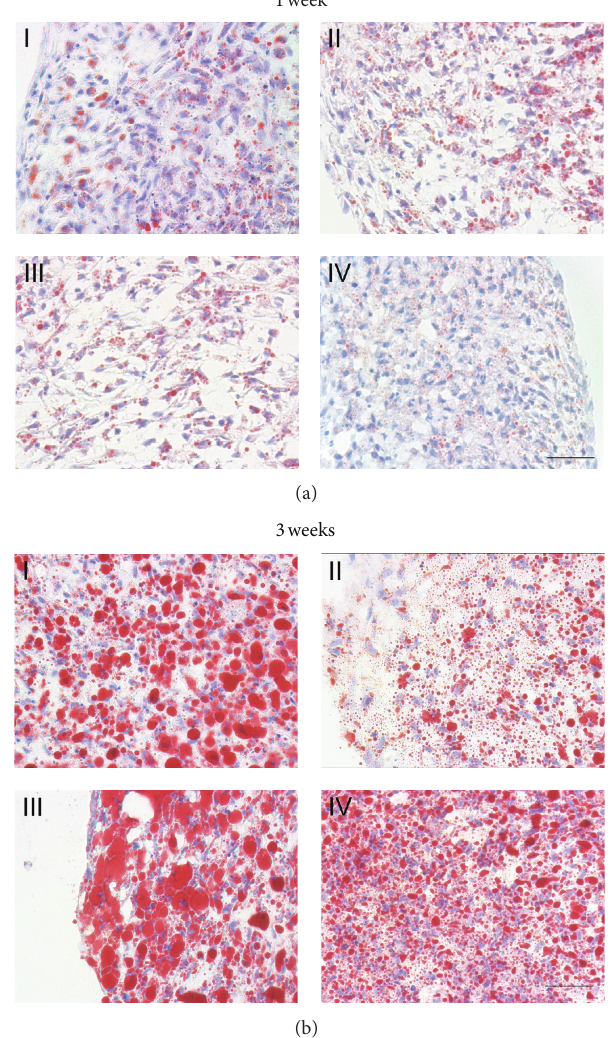
F 1: Effect of initial pelleting medium on MSC